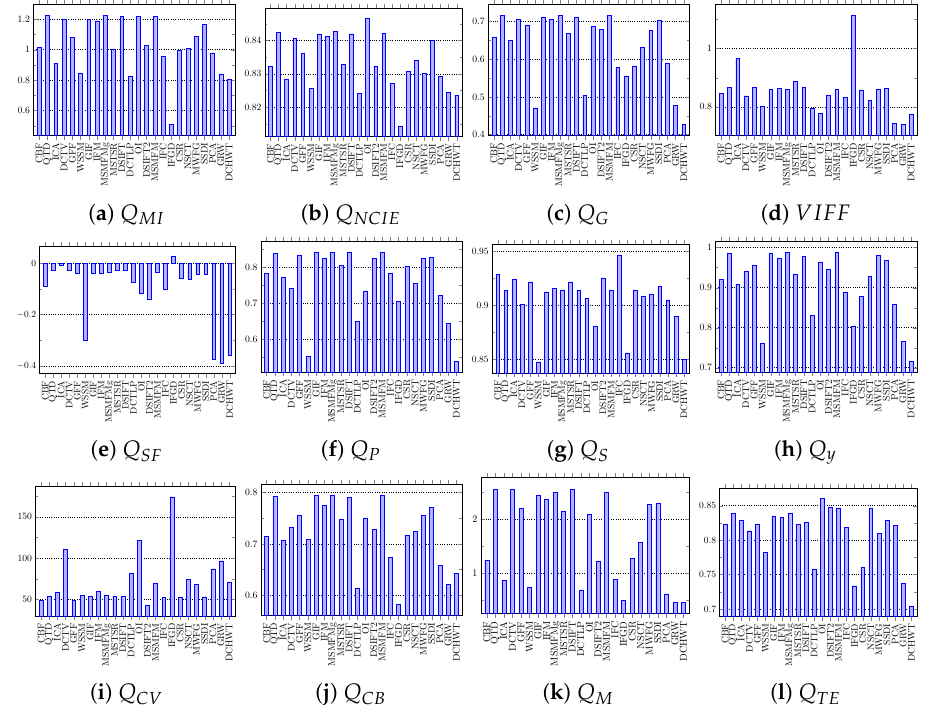
Figure 7. Performance of different image fusion algorithms on the Grayscale dataset using objective fusion quality assessment